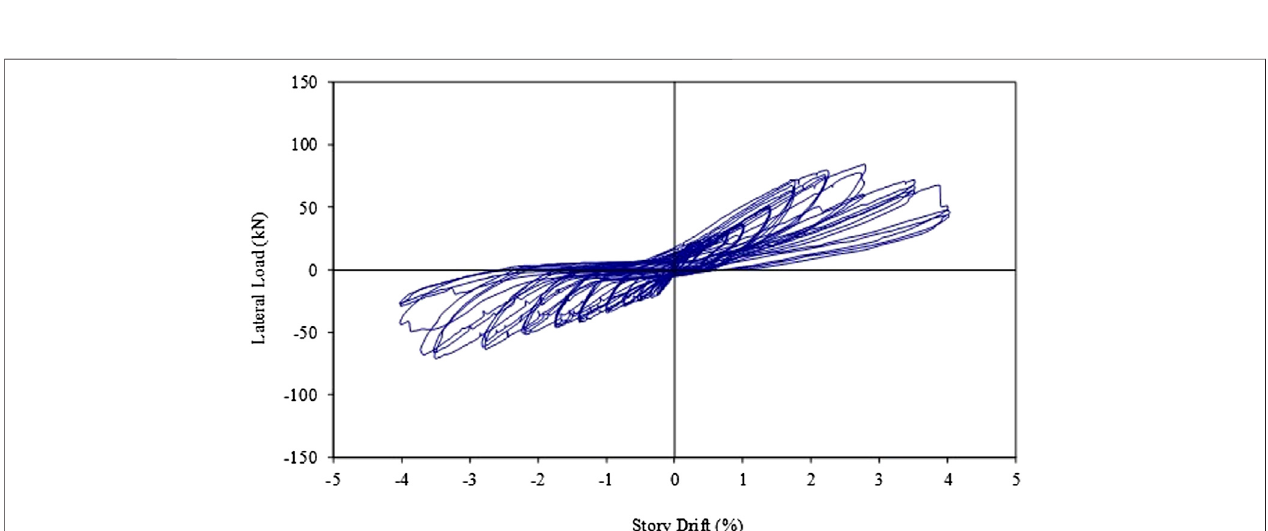
FIGURE 6 | Load — story drift response of specimen MONO_0.